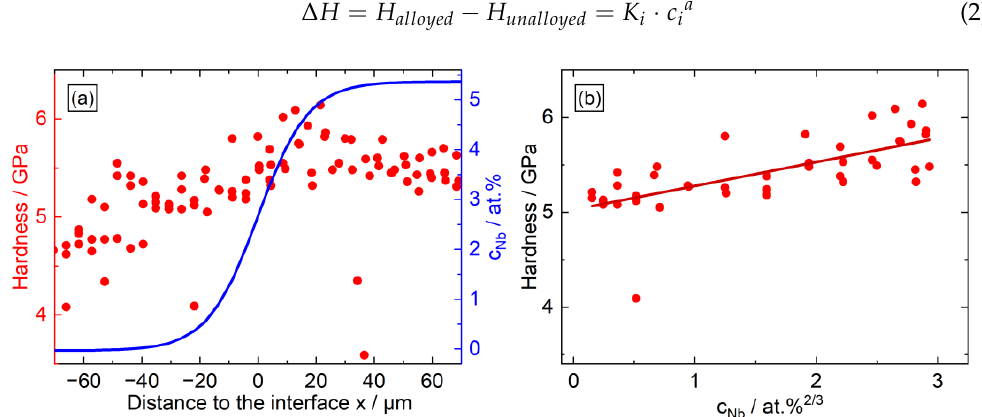
Figure 3. ( a ) Correlation between the hardness determined by nanoindentation and the fitted Nb-concentration across the Ti-54Al/Ti-54Al-5Nb diffusion couple after aging at 1200 °C for 500h and ( b ) the hardness plotted against the Nb-concentration according to the Labusch model (reproduced from Ref. [25]) to determine the solid solution hardening coefficient.